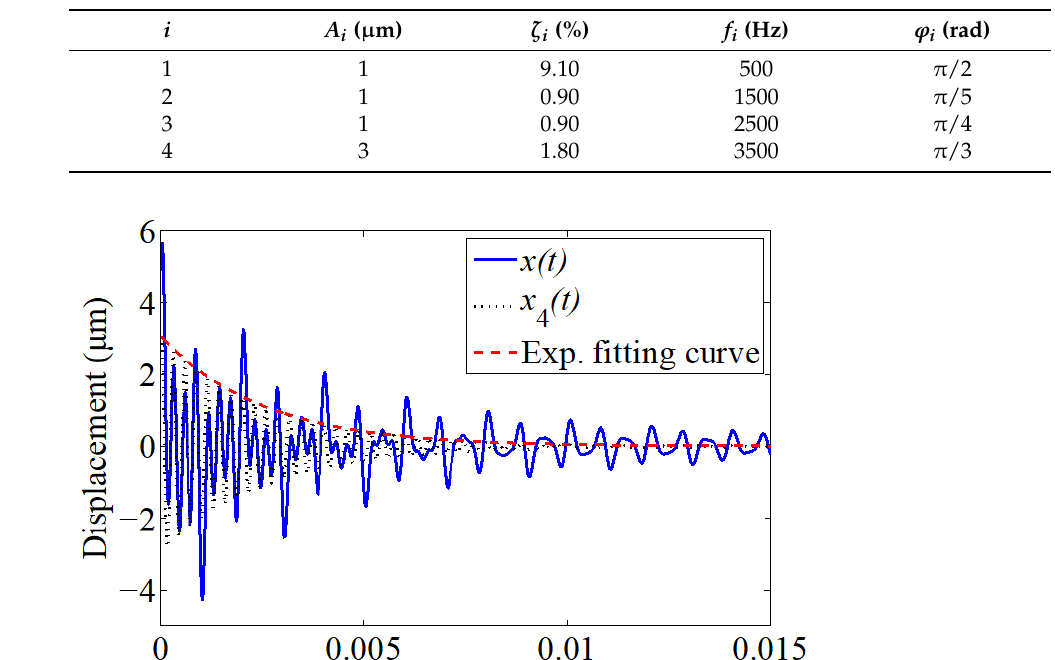
but, within a certain noise range, the identification results still have high accuracy. Table 2. Identified damping ratios with different noise amplitudes. Table 2. Identified damping ratios with different noise amplitudes.